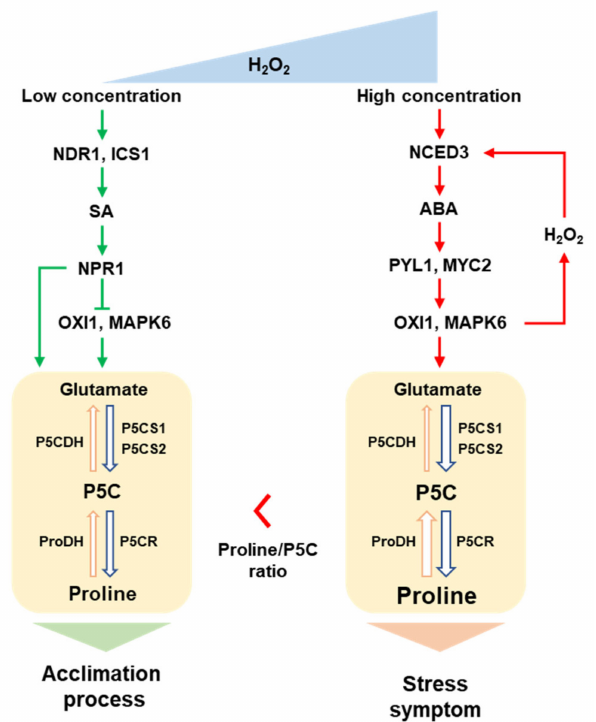
Figure 6. Proposed model of crosstalk between ROS signaling, hormones, and proline metabolism in response to endogenous H 2 O 2 level. Green and red arrows represent the SA- and ABA-dependent pathways,